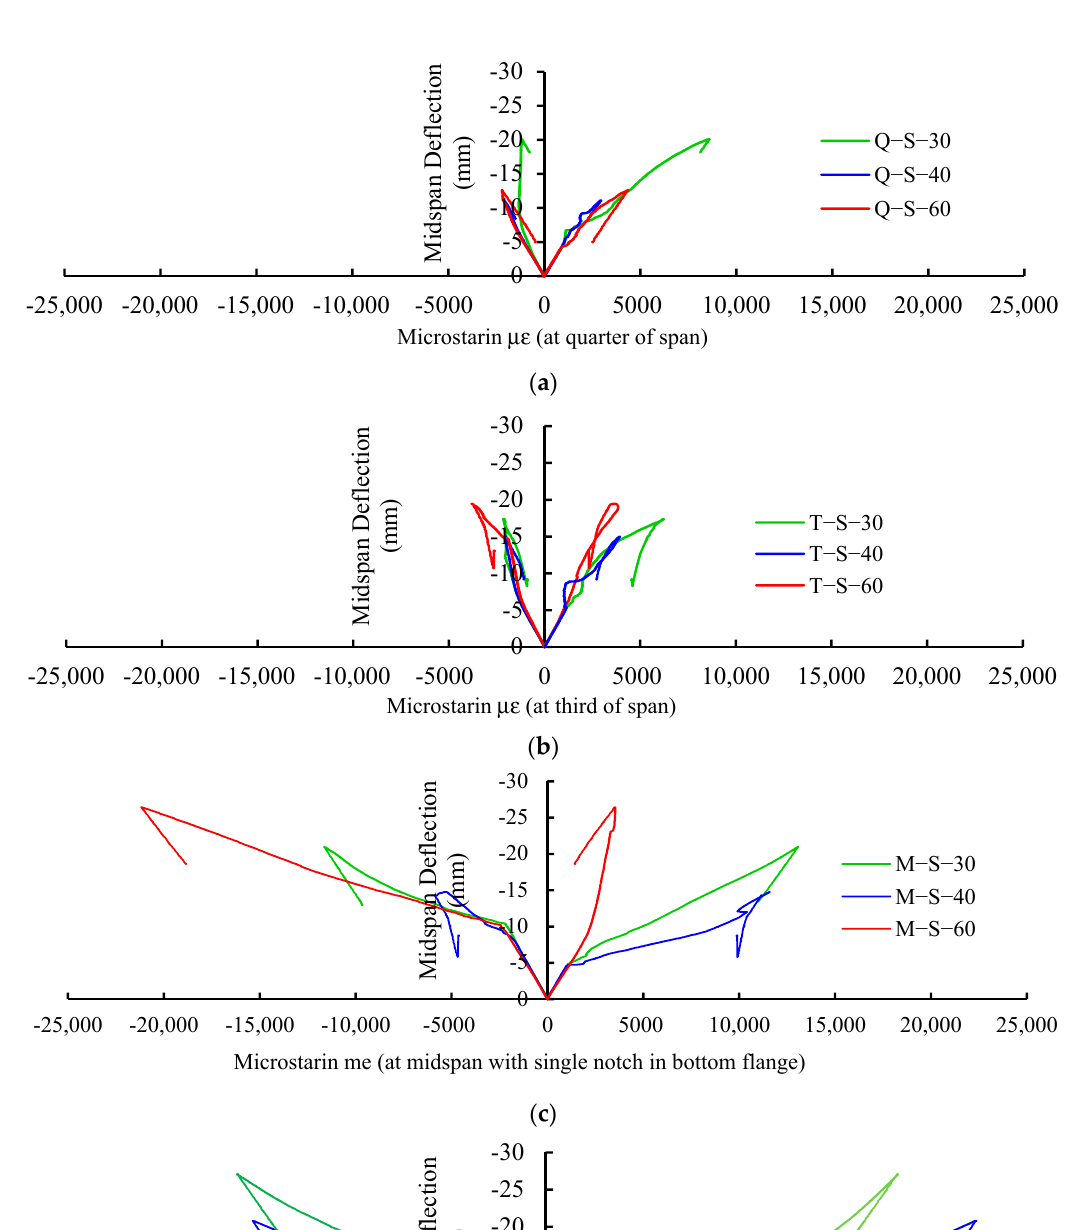
Figure 7. Midspan deflection–strain response of specimens. The test results in Figures 5–7 show that the worst-case scenario in terms of deformations was when the specimens had a notch damage at the midspan. Based on this outcome, the comparison between the numerical and test results focused only on specimens with notch damages at the midspan and the other specimens were excluded.